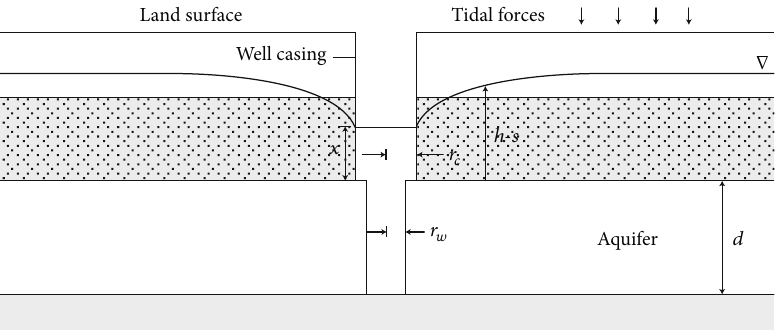
is the inner radius of the casing. r is the screened portion of the well. s c w